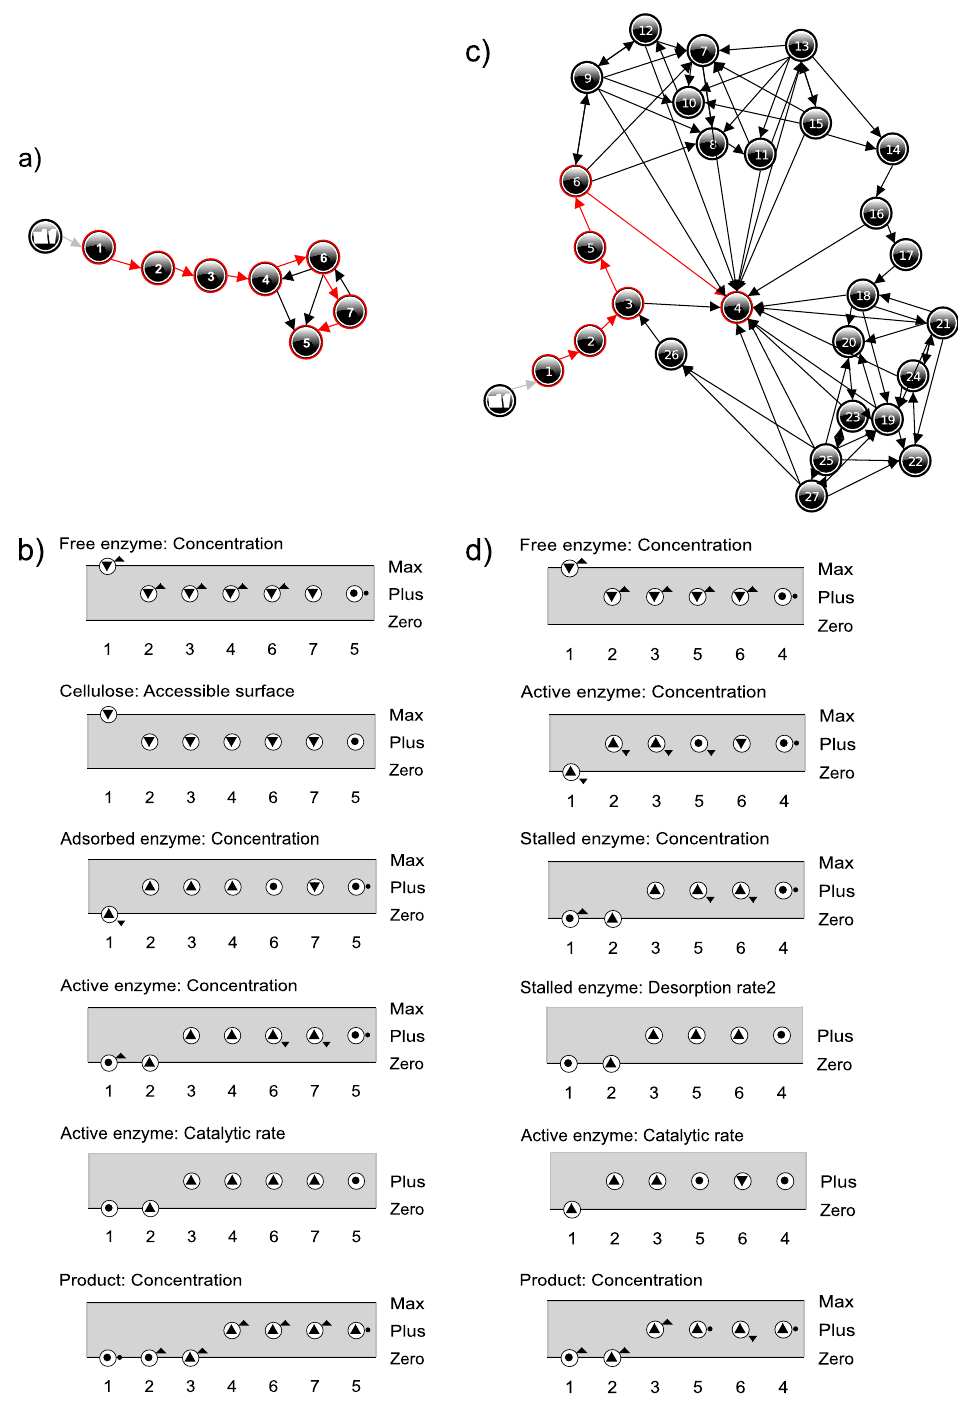
Figure 10. Simulation results for M1 and M2. State-graph of model M1 ( a ). Value histories of selected quantities for model M1 depicting the behaviour path [1 → 2 → 3 → 4 → 6 → 7 → 5] ( b ). State-graph of model M2 ( c ). Value histories of selected quantities for model M2 depicting the behaviour path [1 → 2 → 3 → 5 → 6 → 4] ( d ). See Figs 8 and 9 for an overview of the relations between the quantities of M1 and M2,